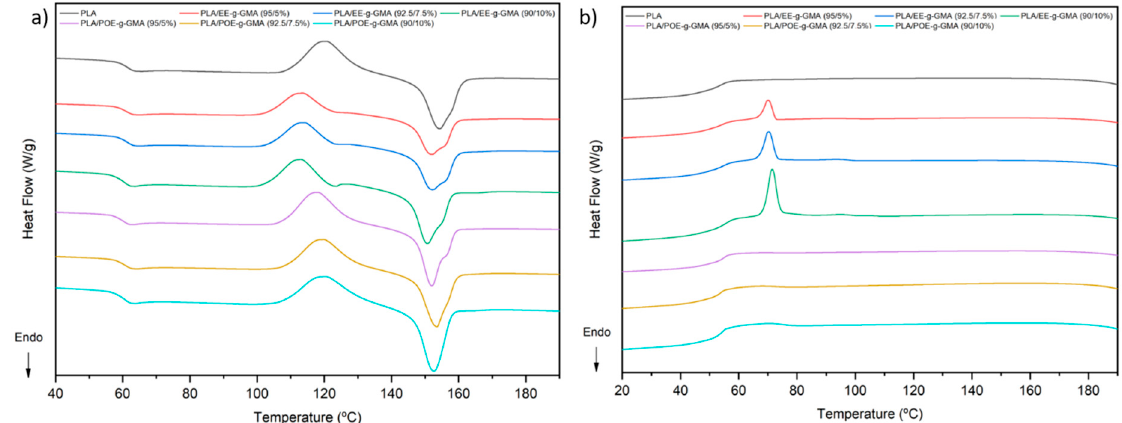
Figure 8. DSC curves of pure PLA and the blends containing 5; 7.5 and 10% EE-g-GMA and POE-g-GMA, ( a ) heating and ( b ) cooling.